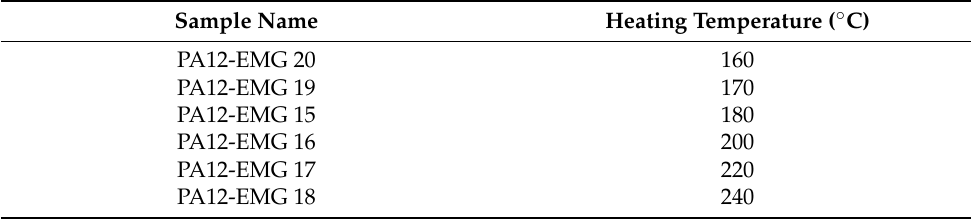
Table 1. Temperature changes during the hot-plate welding of reactive PA12-EMG at constant hold time and constant compaction pressure. The acronym of EMG stands for Elium ® -GMA-Glass composite. The samples are compressed with a compaction pressure of 0.5 MPa and held for a period of 10 min.